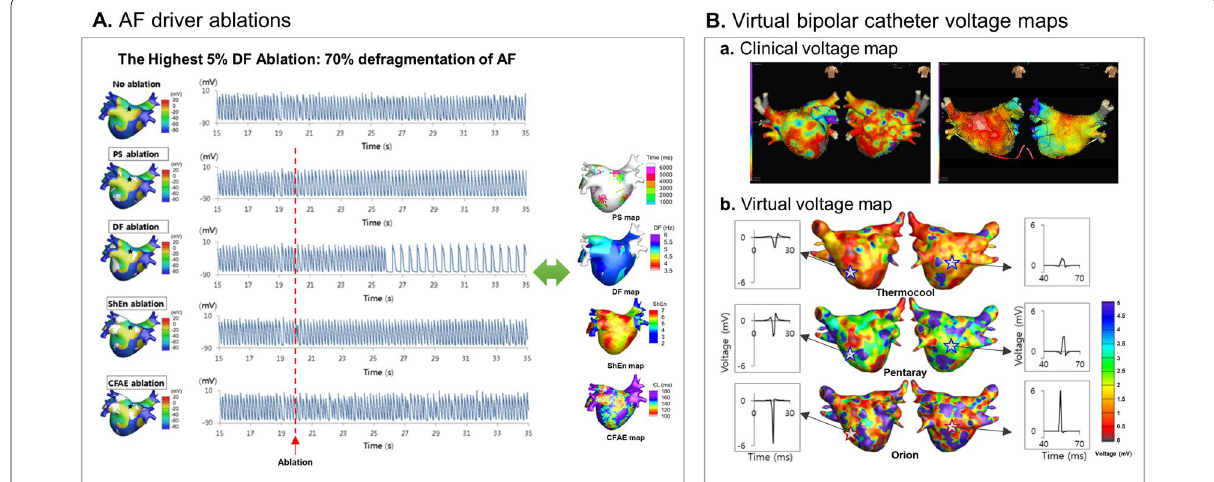
Fig. 4 Visualization of 3D voltage maps, action potential curves, and four different indicators for electroanatomical analysis‑based virtual ablation based on the similarity of clinical versus virtual voltage maps. A Results of four different indicators analyzed in reproducible condition control for AF driver ablation. B Differences in the electrogram amplitudes simulated with three types of multi‑electrode catheters with different electrode sizes and arrangements under the same clinical